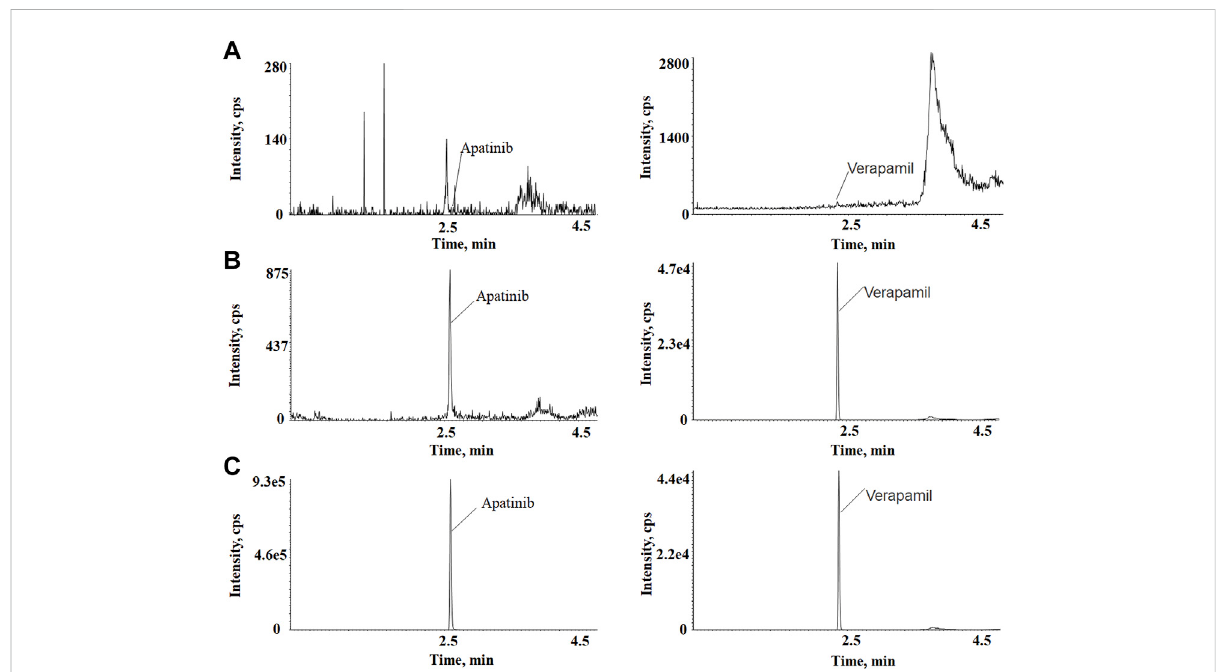
TABLE 1 Intra- and inter-day accuracy and precision of the method for the determination of apatinib in rat plasma (Mean, n = 6). Spiked concentration Accuracy (RE (ng/ml)